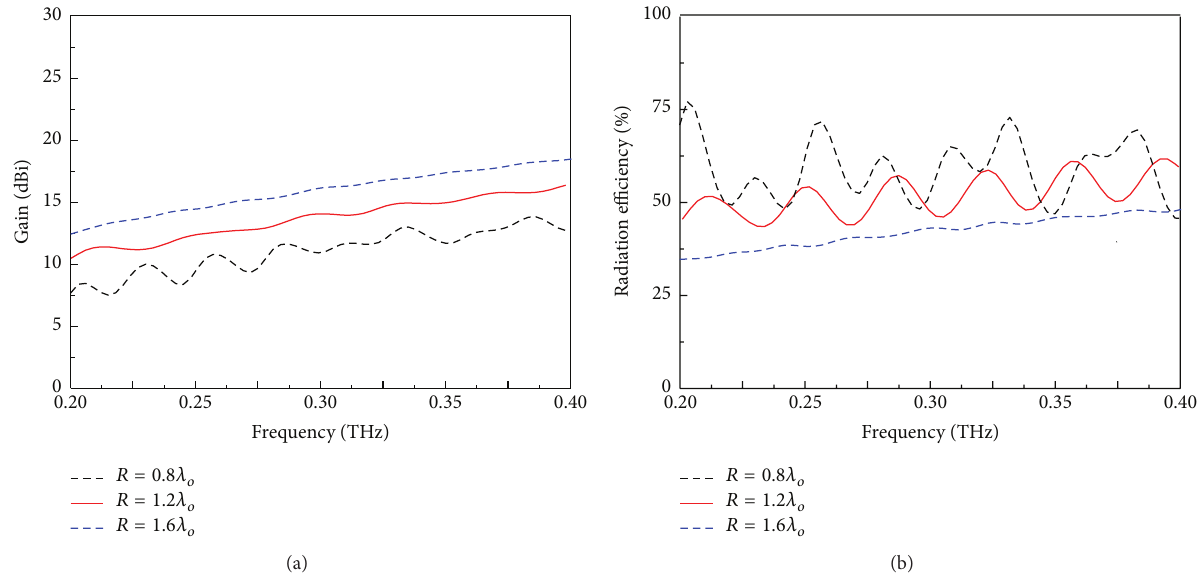
Figure 3: Comparison plots of (a) gain and (b) radiation efficiency for different lens radii with 𝑇/𝑅 = 0.34 compared to frequency.